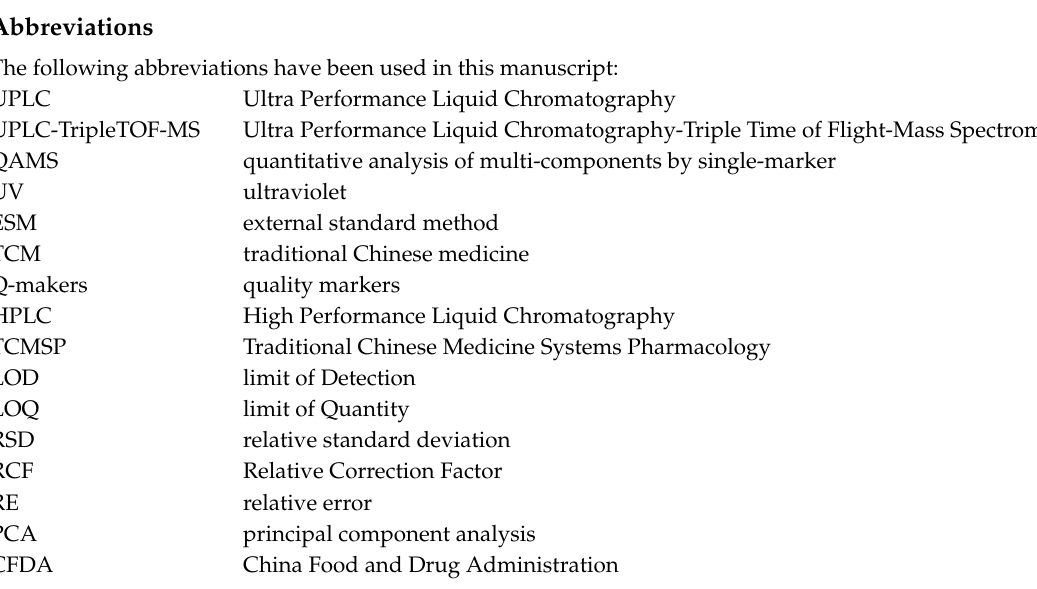
Table S2: The fingerprint technical parameters of 49 common peaks, Table S3: Peak areas of seven determined characteristic